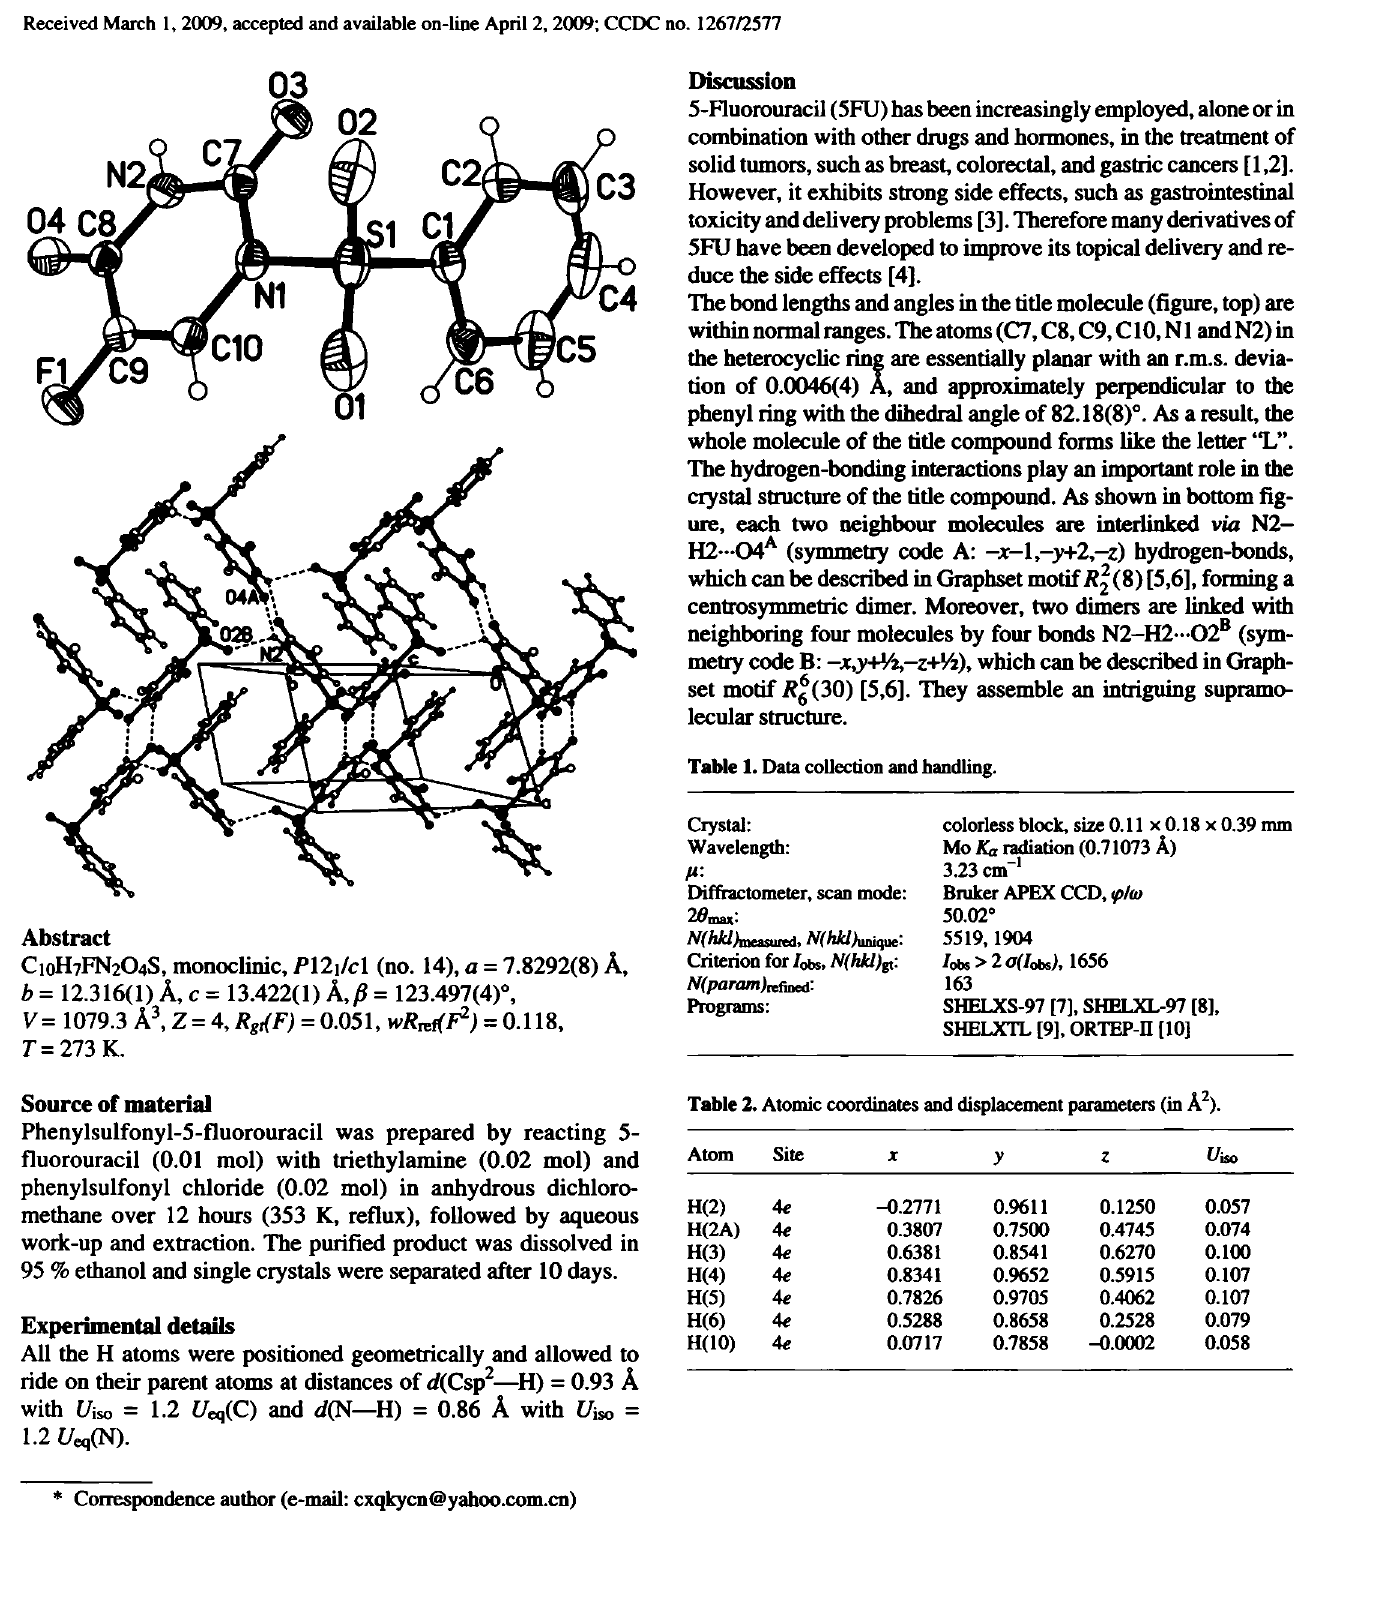
Table 2. Atomic coordinates and displacement parameters (in Â 2